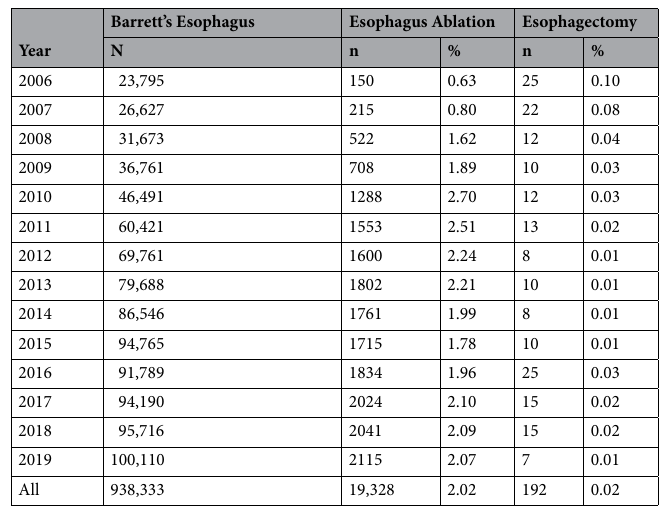
Table 1. Prevalence of esophagus ablation and Esophagectomy in Barrett’s esophagus patients. The values represent the annual number of cases esophagus ablation and Esophagectomy per 10,000 Barrett’s esophagus